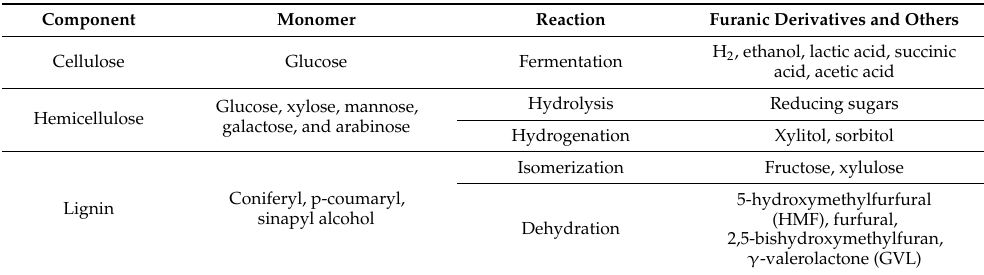
Table 2. Components of lignocellulosic biomass and the derived furanic derivatives and others